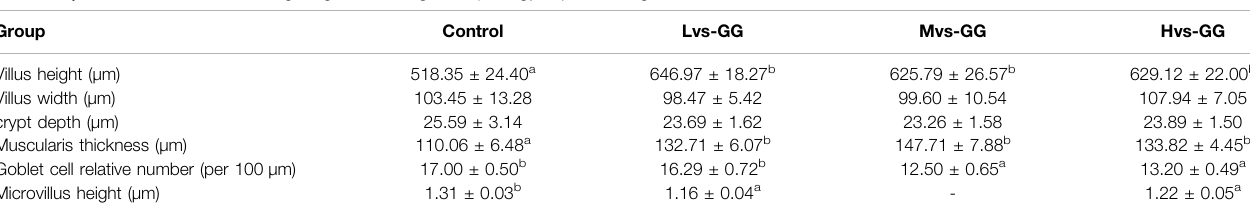
Values are presented as means ± S.E.M ( n = 4). Different superscript letters in the same row means there was a signi fi cant difference between data ( p <